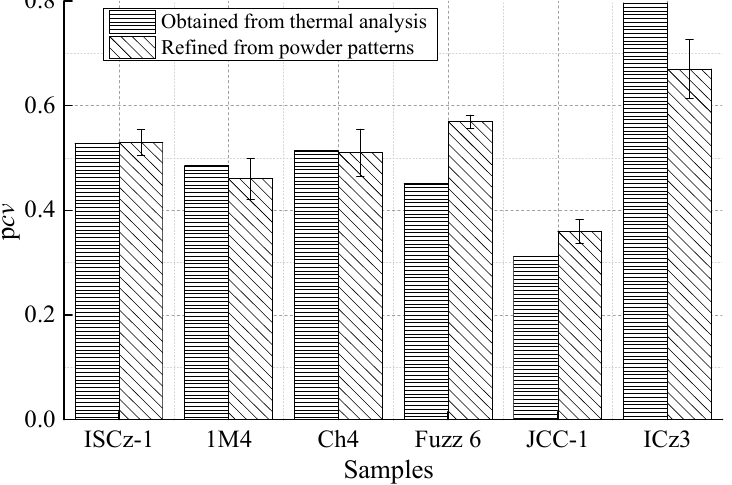
Figure 10. Refined values of probability of cis-vacant layers (P cv ), compared to the values obtained by the thermal analysis.